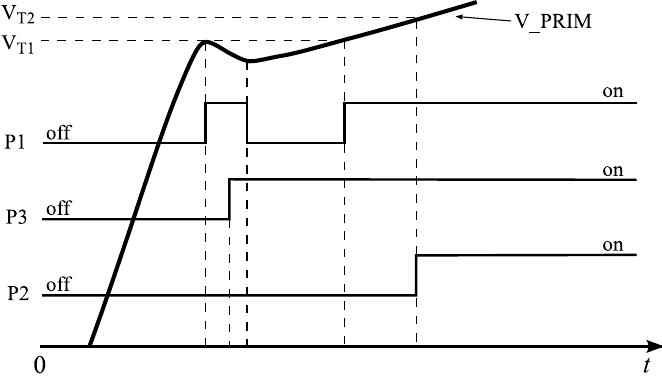
Figure 2. Operation of switches P1–P3 in time domain vs. voltage across the primary energy